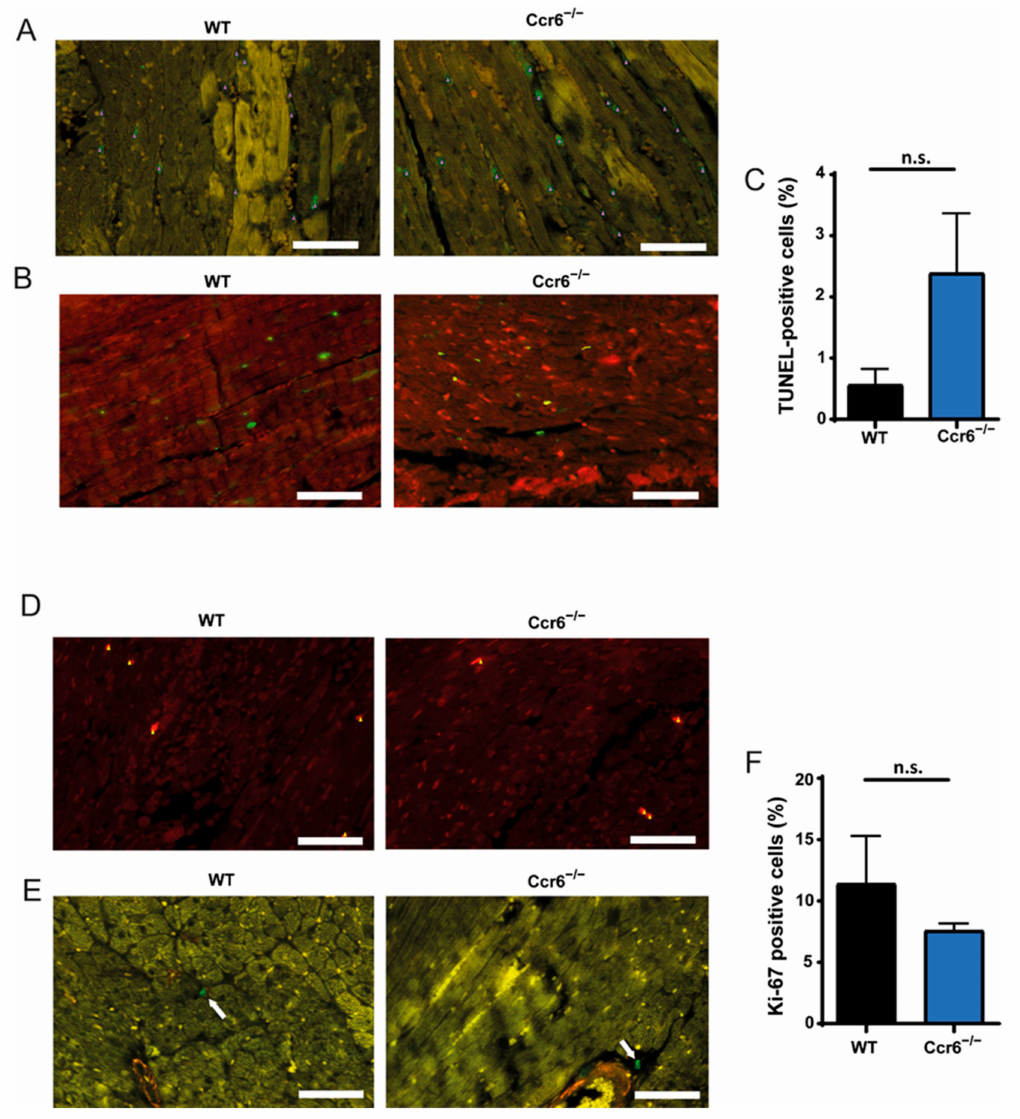
Figure 4. Deficiency of CCR6 results in increased apoptosis, especially in cardiomyocytes, after ischemia-reperfusion injury. ( A – C ) Representative images of TUNEL (Green) staining ( A ) and TUNEL (Green)/Troponin (Red) double staining ( B ), including the quantification of total TUNEL+ cells ( C ), 2 days after ischemia-reperfusion in Ccr6 − / − mice compared to wild- type mice. Scale bar = 50 µ m. ( D – F ) Representative images of Ki67 (Green) staining ( D ) and Ki67 (Green)/smooth-muscle actin (Red) double staining ( E ), including the quantification of total Ki67+ cells ( F ), 2 days after ischemia-reperfusion in Ccr6 − / − mice compared to wild-type mice. Scale bar = 50 µ m. Arrows point at positively stained cells. All n =